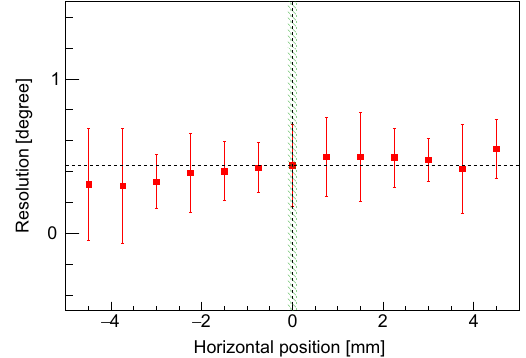
FIG. 11. Dependence of the BSM resolution on the transverse position. The size of the HOPG target was 0 . 2 × 1 . 0 mm 2 and the lens voltage was 4.0 kV. The green hatched region is a target width of 0.2 mm.